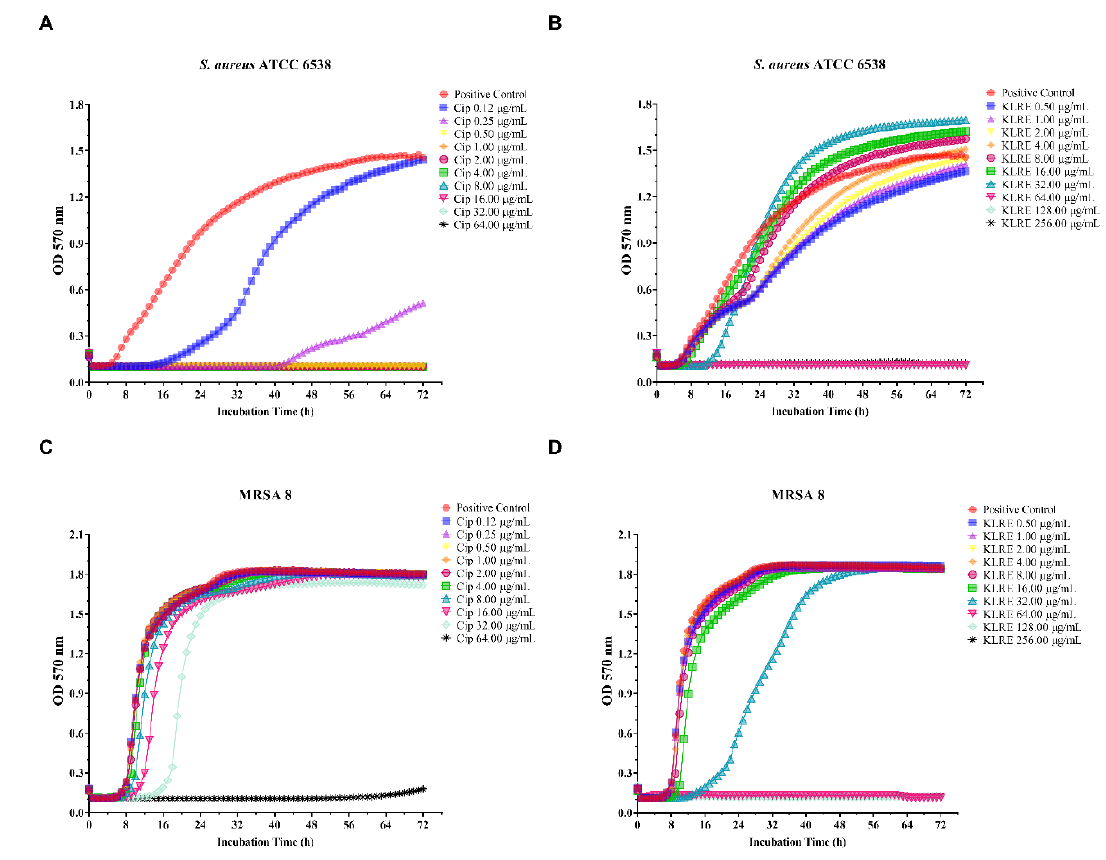
Figure 5. Growth curves of standard S. aureus ATCC 6538 and MRSA 8 exposed to different concentrations of Krameria lappacea root extract (KLRE) or ciprofloxacin, for 72 h. Growth trend of S. aureus ATCC 6538 ( A ) and MRSA 8 ( C ) untreated (positive control) and treated with increased concentrations of ciprofloxacin (Cip) ranging from 0.12 to 64.00 µ g/mL. Growth trend of S. aureus ATCC 6538 ( B ) and MRSA 8 ( D ) untreated (positive control) and treated with increased concentrations of KLRE, ranging from 0.50 to 256.00 µ g/mL. In the x-axis is reported the incubation time; in the y axis, the OD 570 values of the two tested bacterial strains.